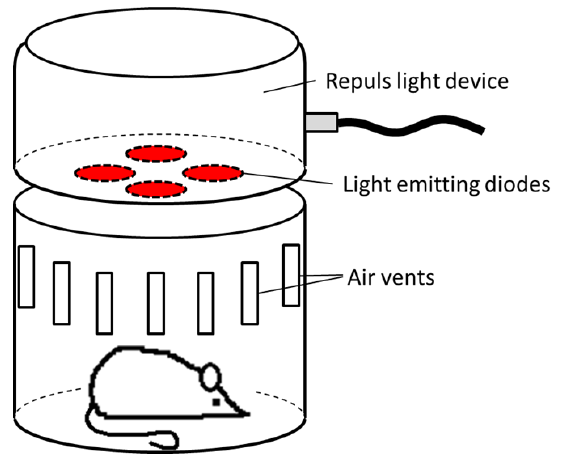
Figure 11. Scheme of PBM treatment of db/db mice in a container fitting the diameter of the LED device by Repuls.